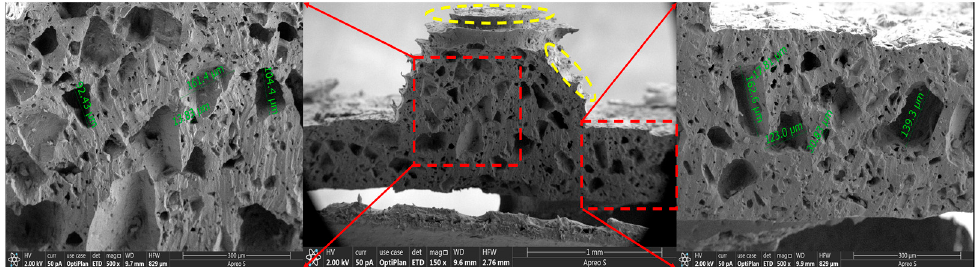
Figure 9. Cross-section SEM image of the dielectric layer of sensor Ⅰ (the porous microstructure in the red area, and the hemispherical microstructure in the yellow area).